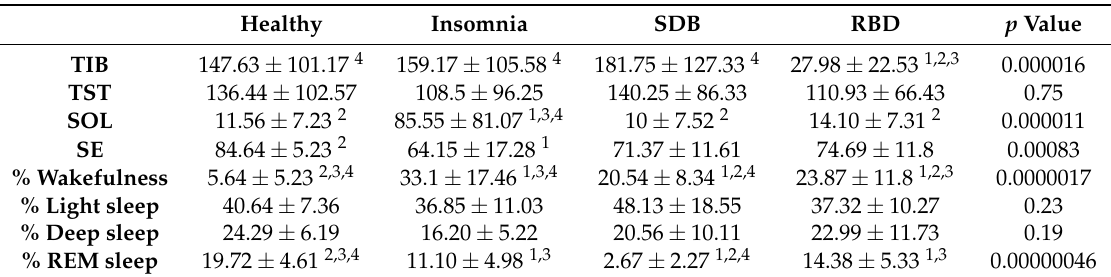
Table 7. One-way ANOVA and post hoc Scheffe test to evaluate the importance of sleep quality parameter.s